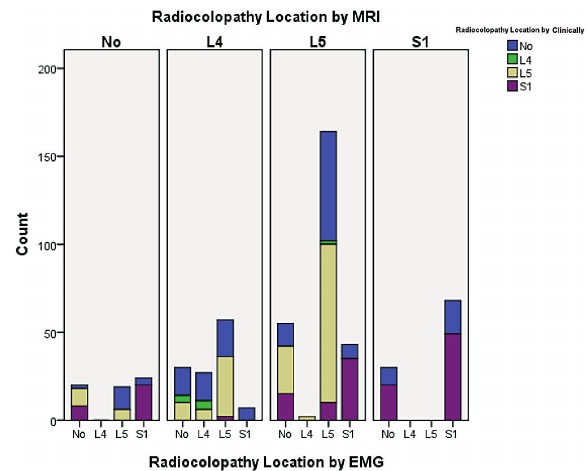
Figure 3. The frequency distribution of radiculopathy level based on MRI, EMG and clinical